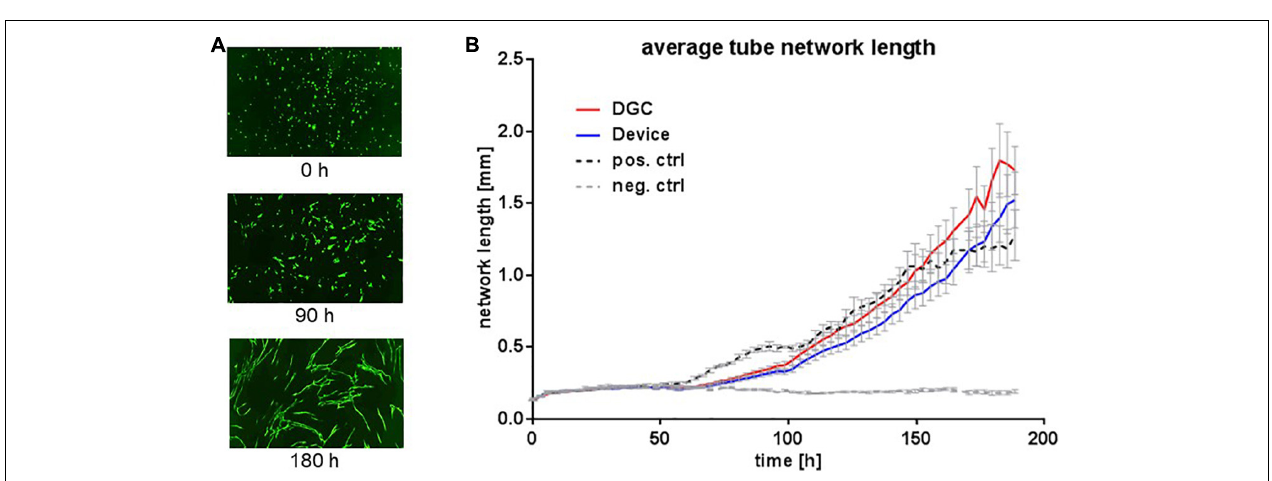
FIGURE 8 | In vitro vascular tube formation potential. Vascular tube formation assay to assess the potential of MSCs at P3 to support in vitro vasculogenesis. Exemplary microphotographs from life cell imaging show eGFP + HUVECs forming vascular tube networks in vitro at start (0 h), proceeding (90 h), and complete network formation (180 h) (A) . Images captured with 10 × objective in the IncuCyte ZOOM system. Quantification of average vascular tube network length in millimeters (B) . Each data point represents means of biological replicates ( n = 5 donors). Error bars: SEM. Two-way